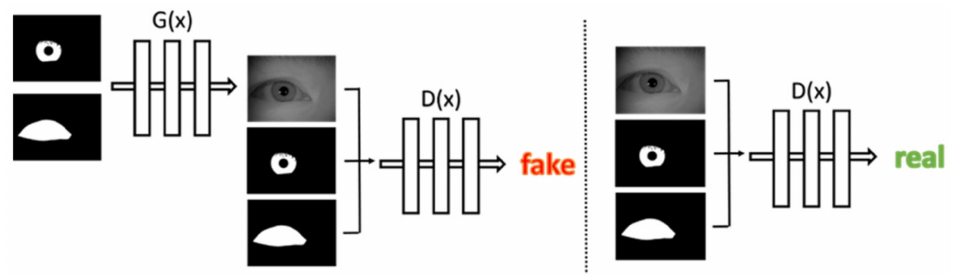
Figure 2. Proposed method training architecture.